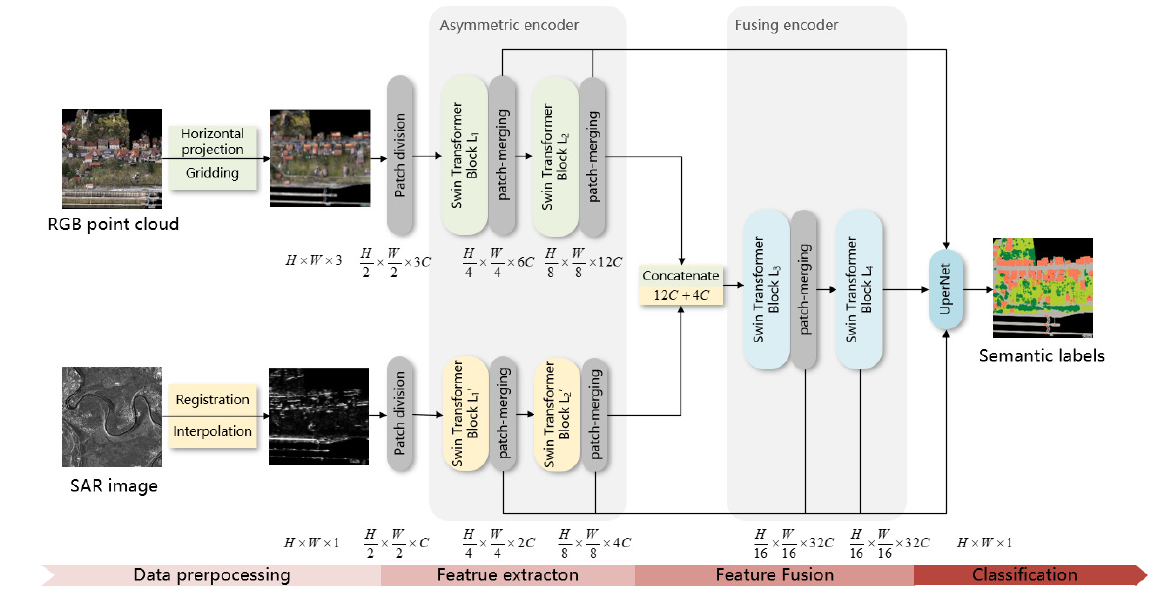
Figure 1 . Structure of the proposed